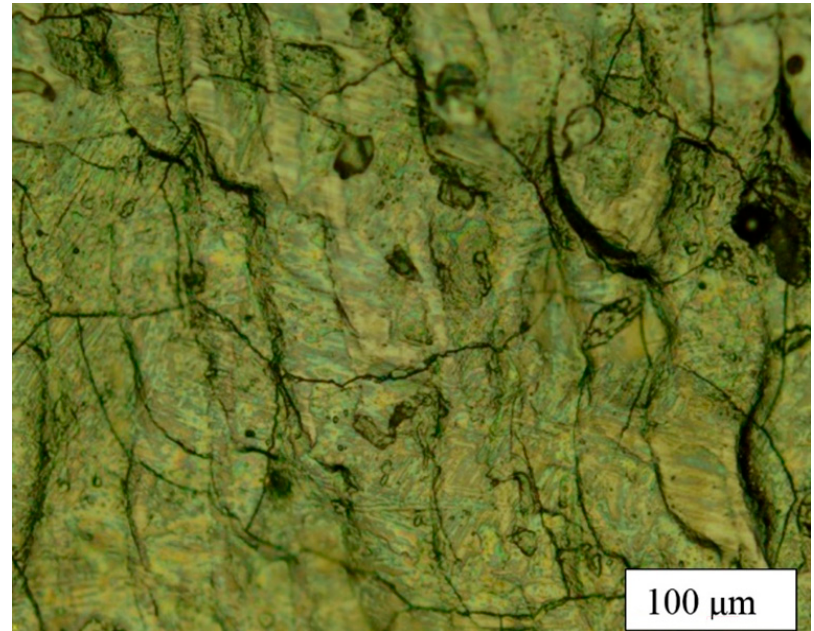
Figure 13. Cracks in the material 50 wt% WC and 50 wt% Co (micron fraction Co), top view.